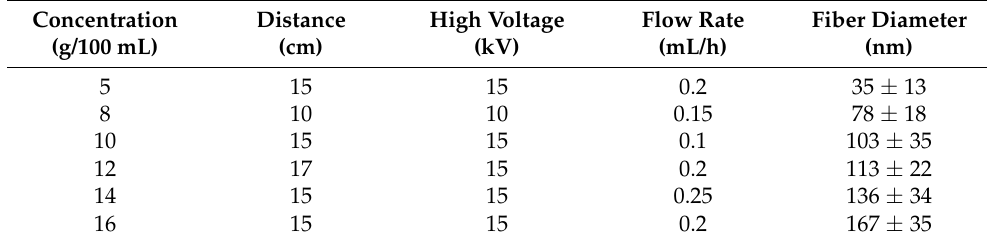
Table 1. Parameters for the electrospinning of PCL scaffolds from spinning solutions with varying concentrations from 5 g/100 mL to 16 g/100 mL and resulting fiber diameters.